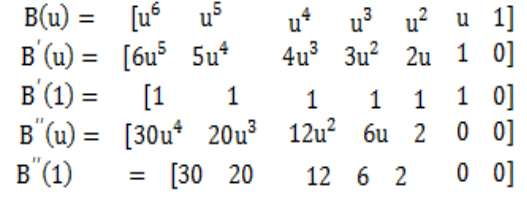
Fig. 6. Continuity for curves of C 1 Bezier